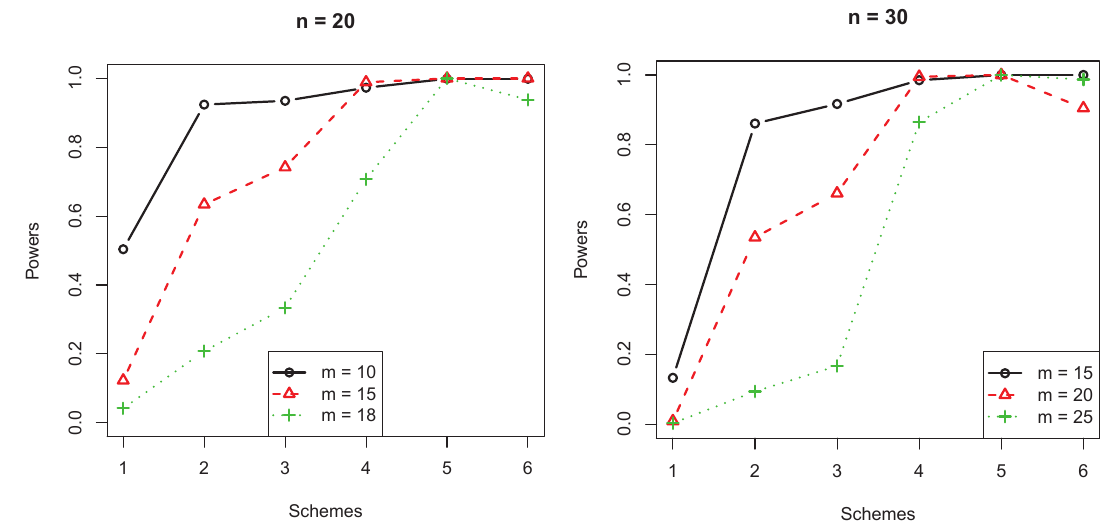
Figure 4. Powers of different schemes for the monotone increasing hazard function Rayleigh(0.2) for the ˆCKL test, in the case of n = 20 and